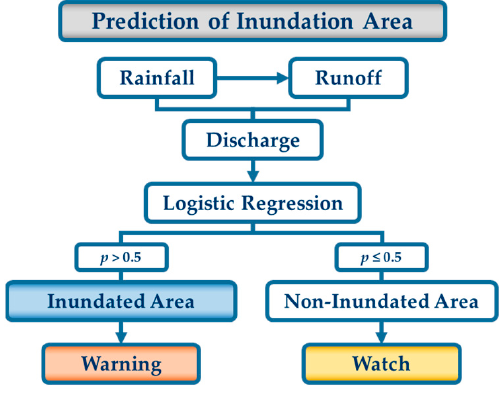
Figure 3. Prediction process of inundation grid.